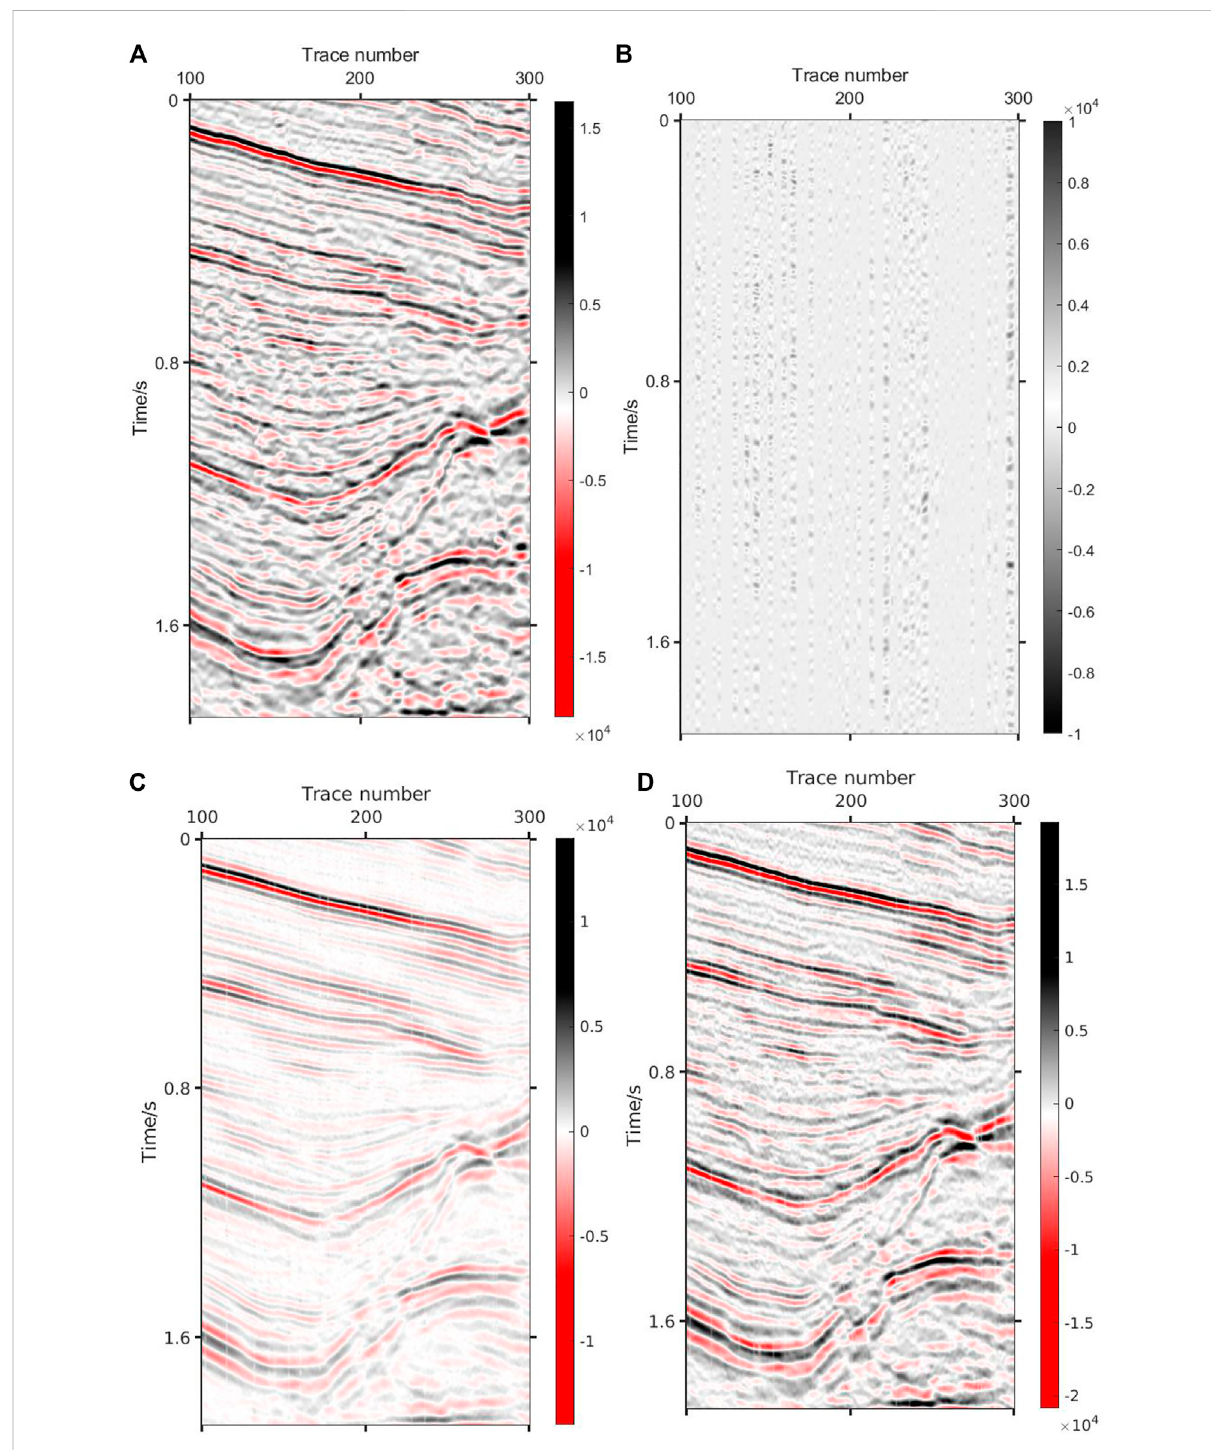
FIGURE 8 Result via Curvelet+DCT. (A) Result via Curvelet+DCT (SNR=11.45 dB PSNR=27.79 dB); (B) Absolute error via Curvelet+DCT; (C) Reconstruction component via Curvelet; (D) Reconstruction component via